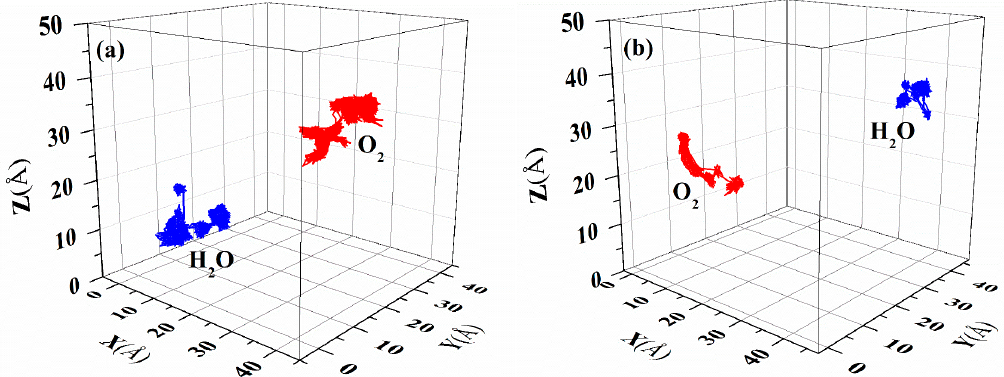
Figure 10. Representative trajectories of O 2 and H 2 O in ( a ) DABPI and ( b ) m-DABPI. The relationship between MSD and time was plotted on logarithmic scales (Figure 11).